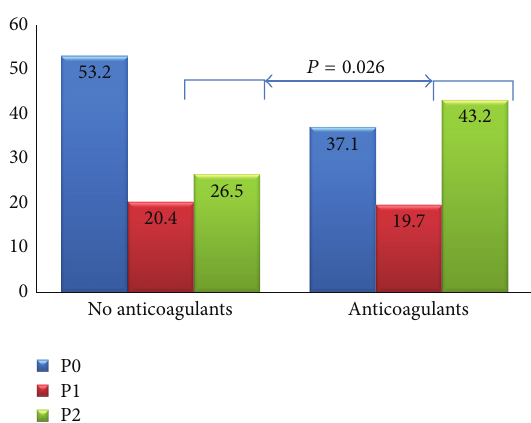
Figure 1: Prevalence (%) of SBCE bleeding lesions with and without anticoagulant drugs.